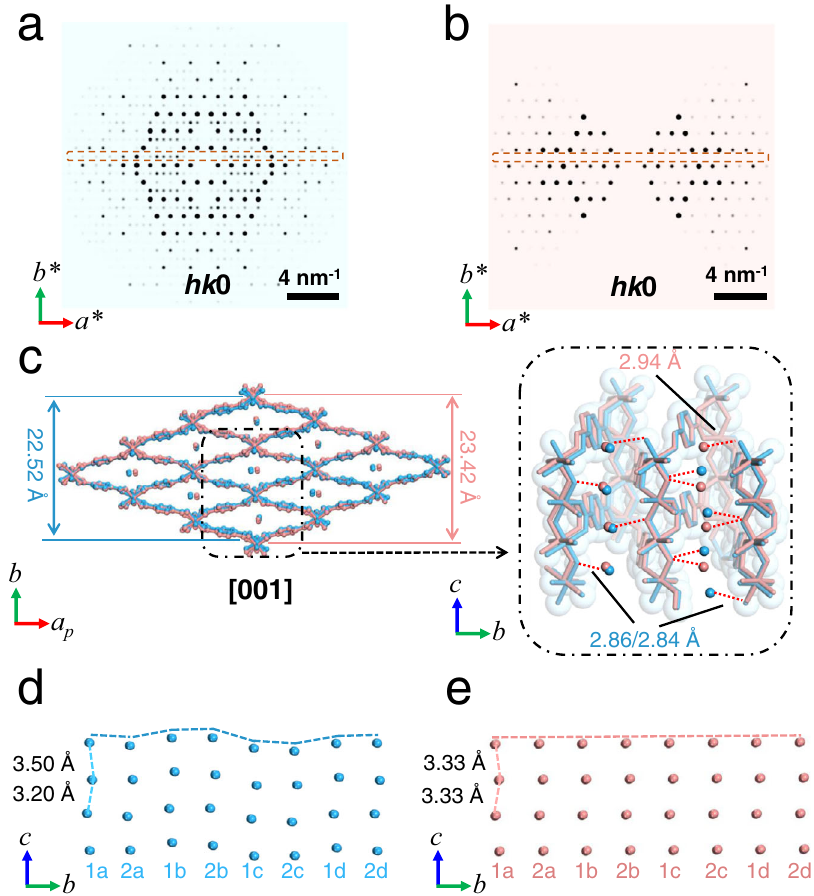
Fig. 3 | Comparison of two structures obtained from crystals under different environments. Theslicesat hk 0planecutfromreconstructedreciprocallatticeof data of ( a ) MIL-53 lt -cryo and ( b ) MIL-53 lt -gas (air). Compared with b , extra re fl ec- tions can be clearly observed in a as shown in the dashed boxes, indicating the structural change after the cryogenic sample preparation. For a better display, re fl ectionintensitiesare0.8poweroforiginalvalues. c Overlapoftwostructuresof MIL-53 lt -cryo (blue) and MIL-53 lt -gas (air) (pink). The inset shows possible hydro- genbondsbetweenoxygensites(guestH 2 Omolecules)andbridgingoxygenatoms in the framework, distances of which are 2.86Å or 2.84Å for MIL-53 lt -cryo and